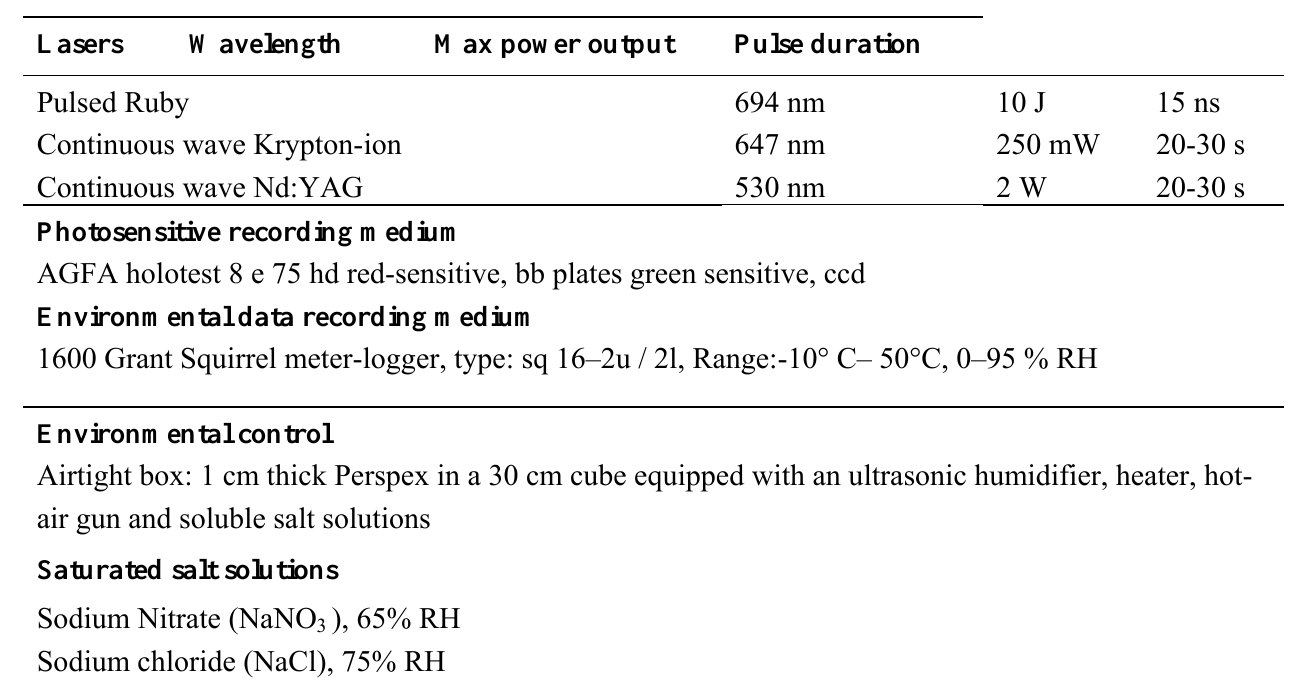
Table 1. Laser and Environmental